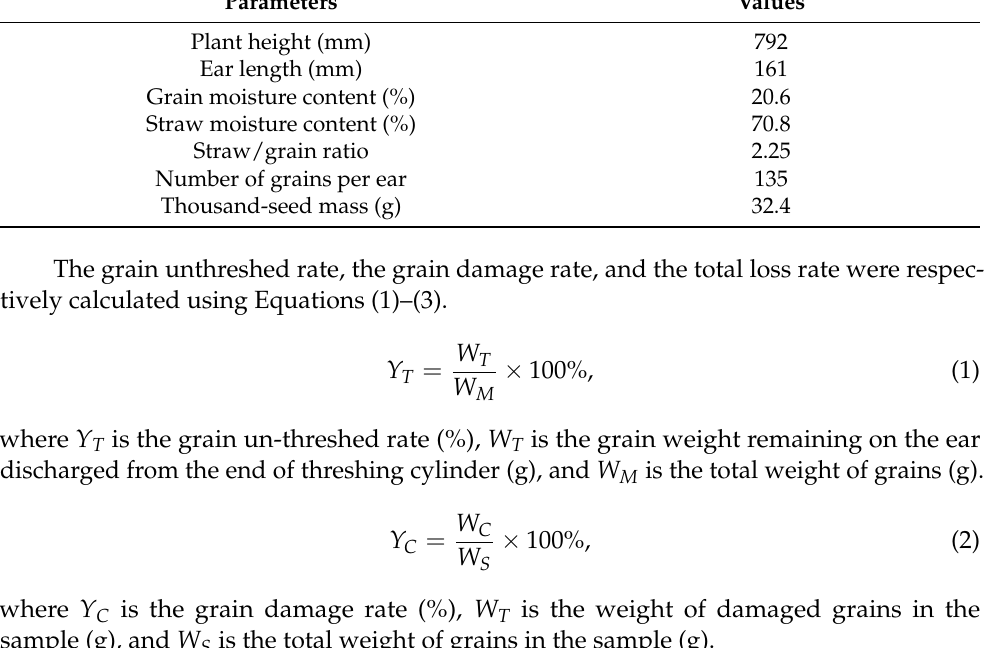
Table 5. Physical properties of “Jia Hua” rice.